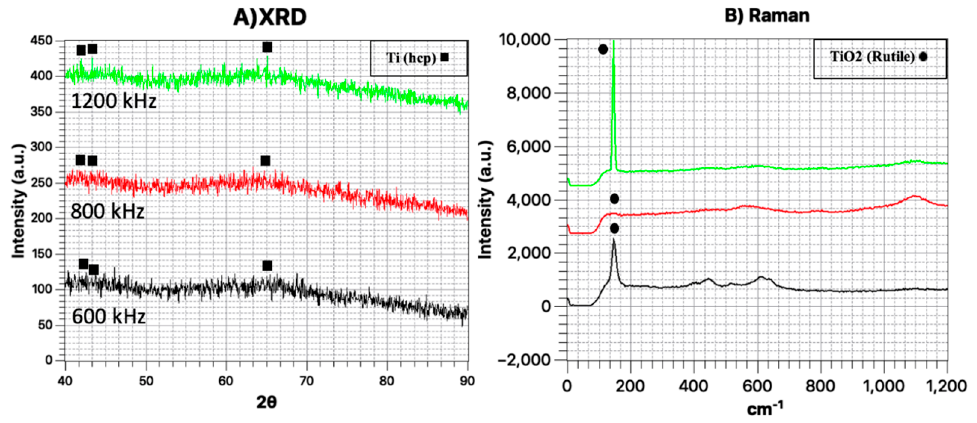
Figure 11. ( A ) XRD pattern and ( B ) Raman spectrum of glass samples coated by titanium with different laser frequencies.